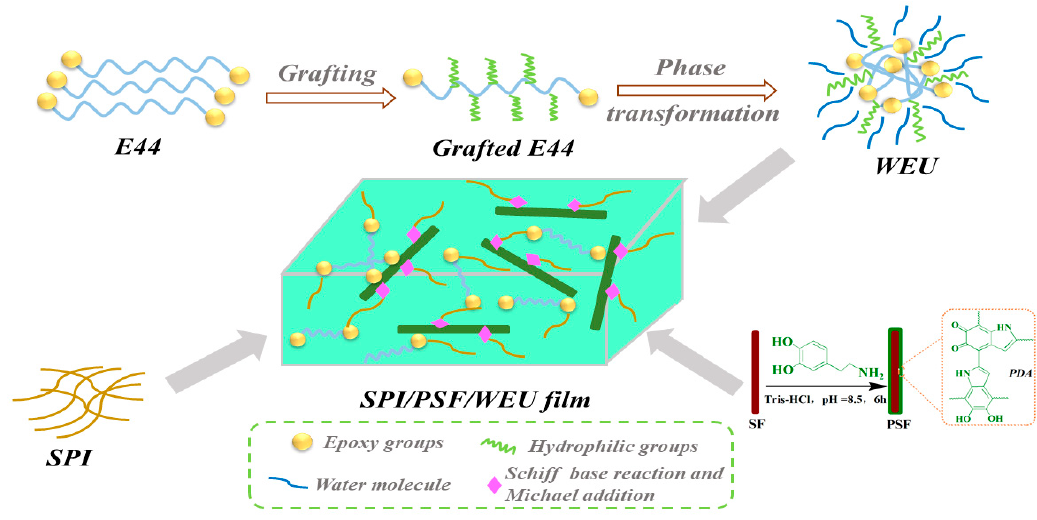
Figure 3. The digital imagines of SPI, SPI/WEU, SPI/SF, SPI/PSF, and SPI/PSF/WEU films.